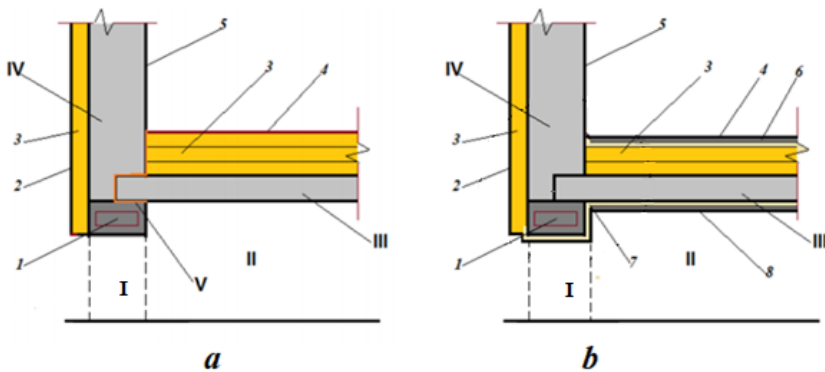
11 of 15 Figure 7. Installation of a floating floor in an industrial building: ( a ) — laying of rolled polyethylene foam on the prepared base and formation of a seamless shell; ( b ) — installation of reinforcement frames and pouring of concrete; ( c ) — installation of heavy equipment on the industrial floor. As already noted, polyethylene foam and seamless insulation shells have low ther- mal conductivity and permeability. These properties make them promising for the de- velopment of insulation systems for buildings and construction operating in the polar region. Subzero temperatures and high wind loads are typical for the polar region. Tak- ing into account the necessity of preserving permafrost, pile structures are the prevailing